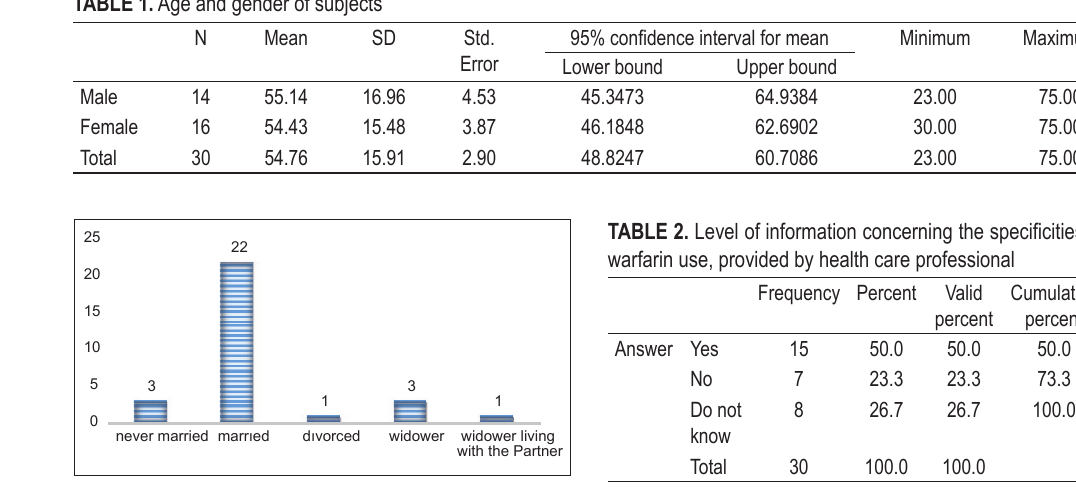
Figure 1. Marital status of subjects.